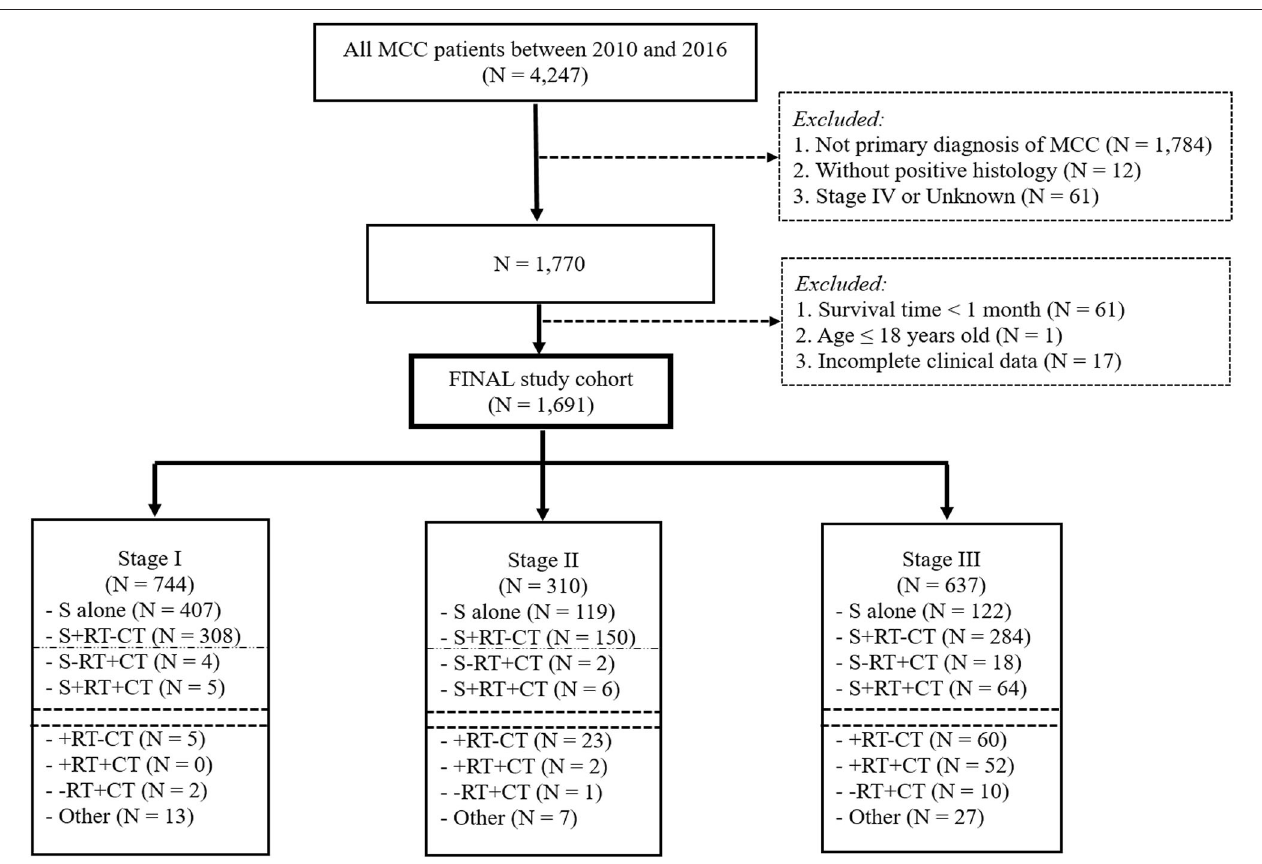
FIGURE 1 | Patient selection